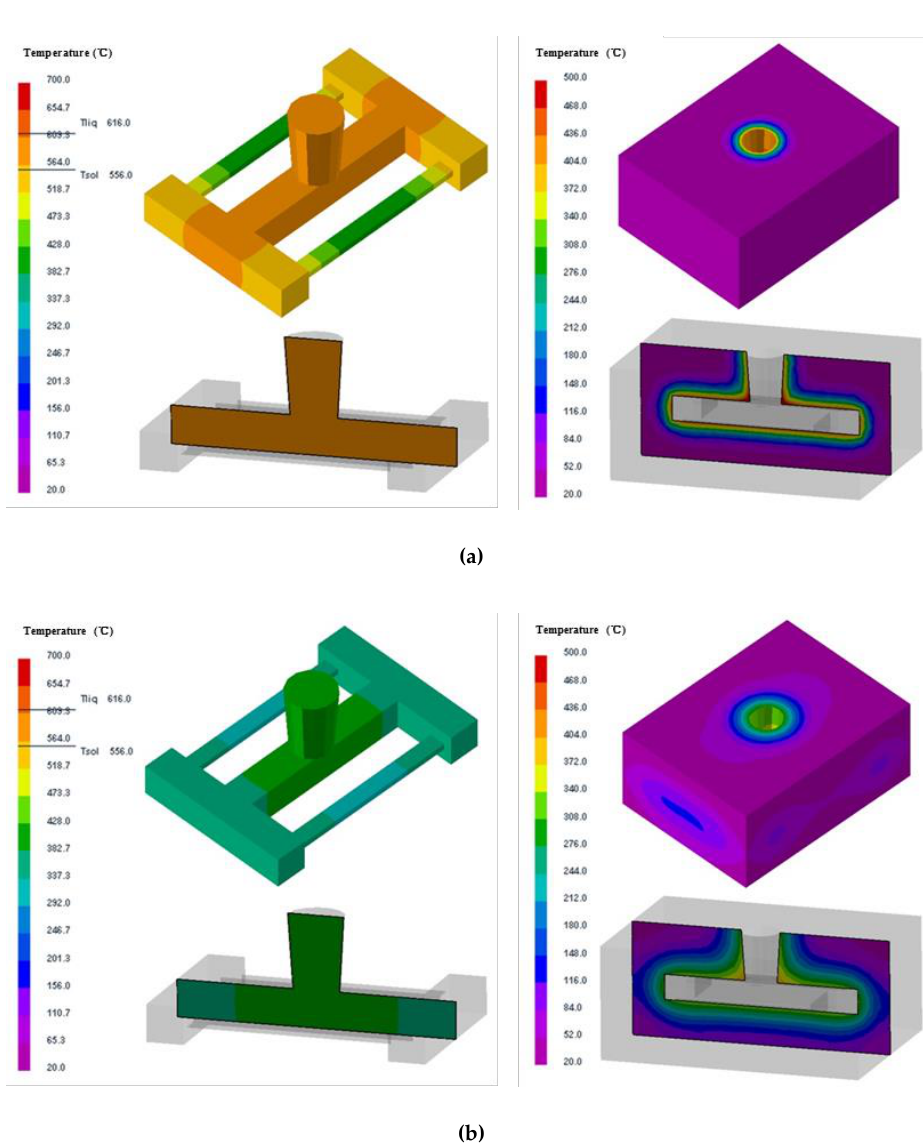
Fig ure 7. The temperature fields of the skeletal sand mold and casting: (a) 500 s; (b) 1500 s and (c) 4500